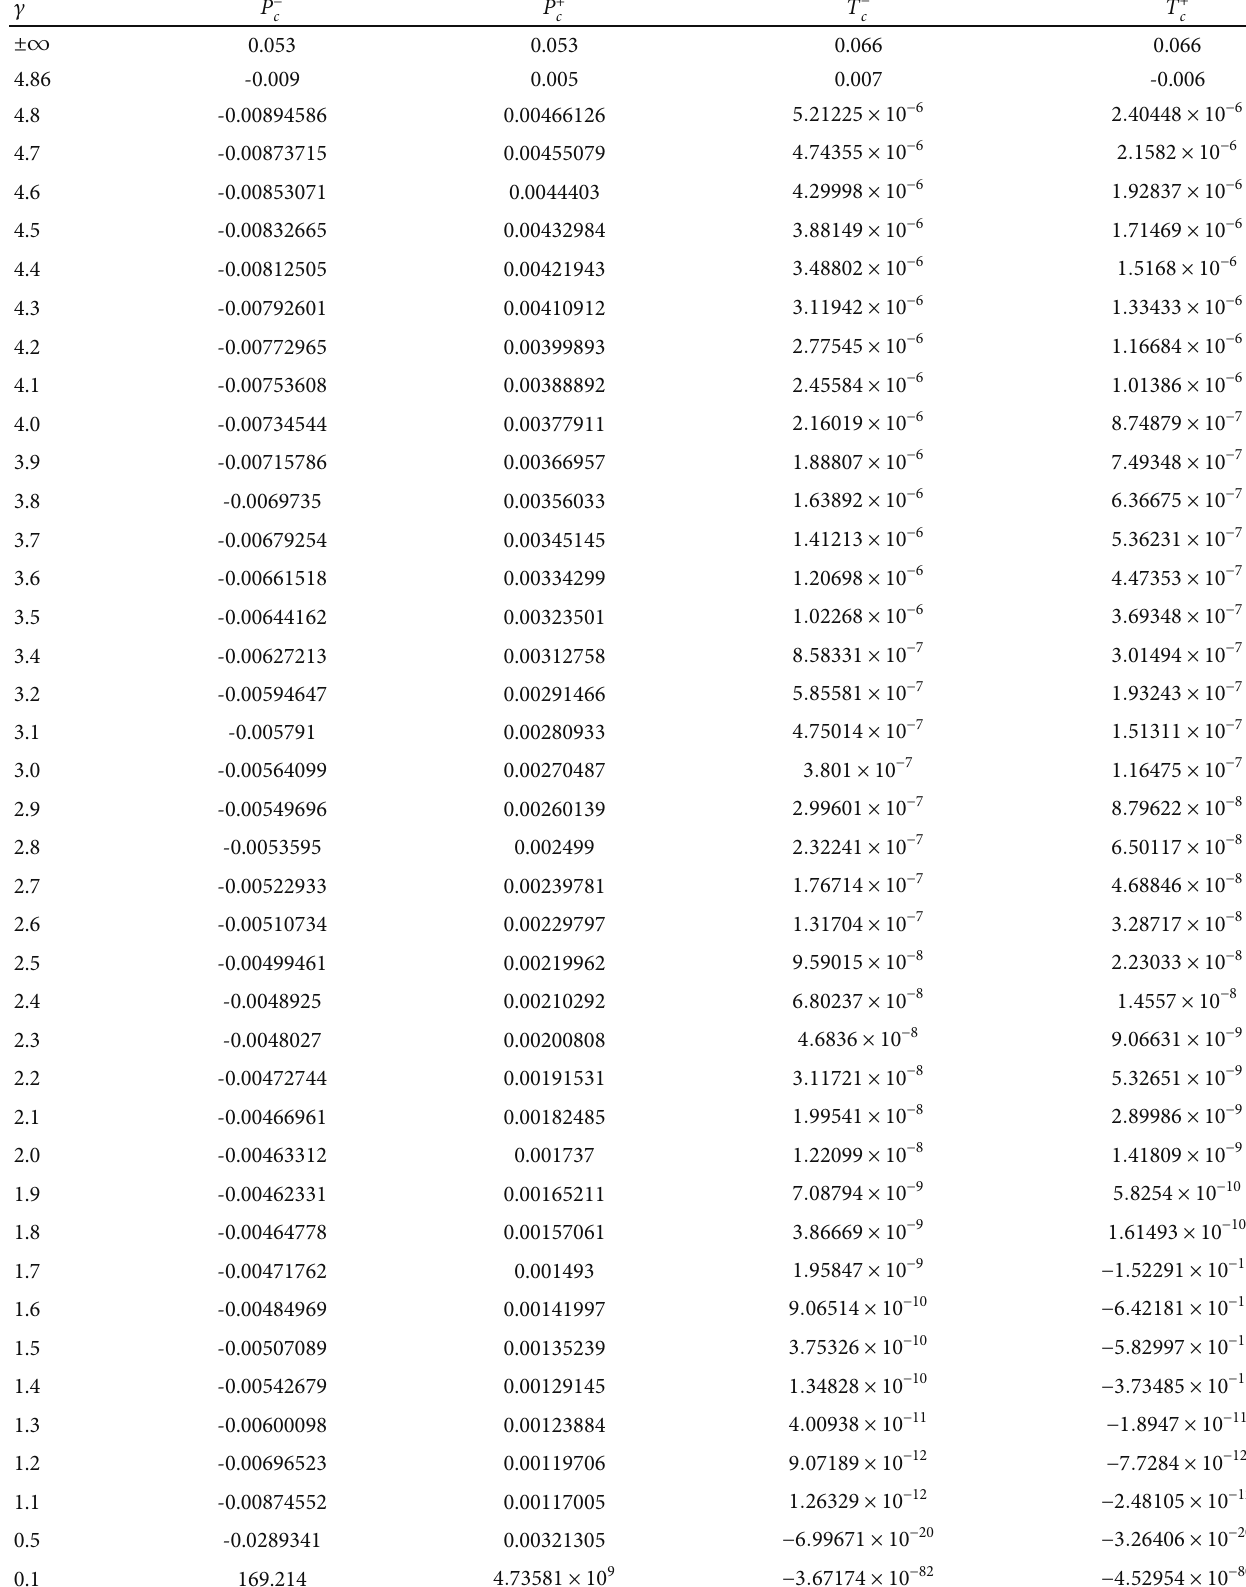
Þ and small ð P − , T + c c